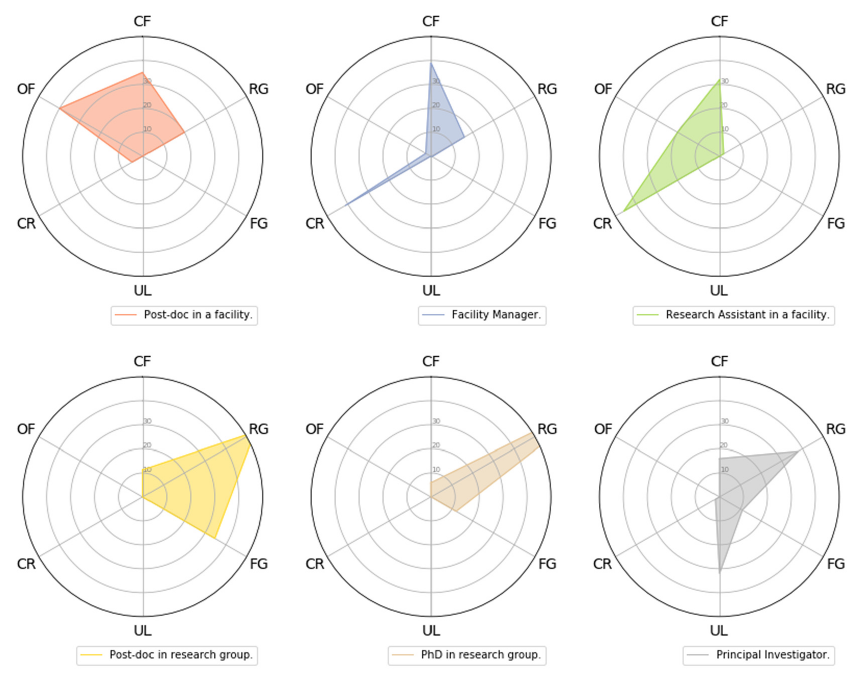
Figure 9. Radial plots displaying answers to question 2.5. Participants were asked to gauge the approximate funding contributions (0–100%) of their position from the following sources: CF (Core Facility), RG (Research Grants), UL (University Lectureship), FG (Fellowship Grant), CR (External and Internal Cost Recovery), OF (Other funding). Center, 0% funding, Outside Circle, 100%, each graduation represents 20%. Values in each category were averaged over each class of participant.